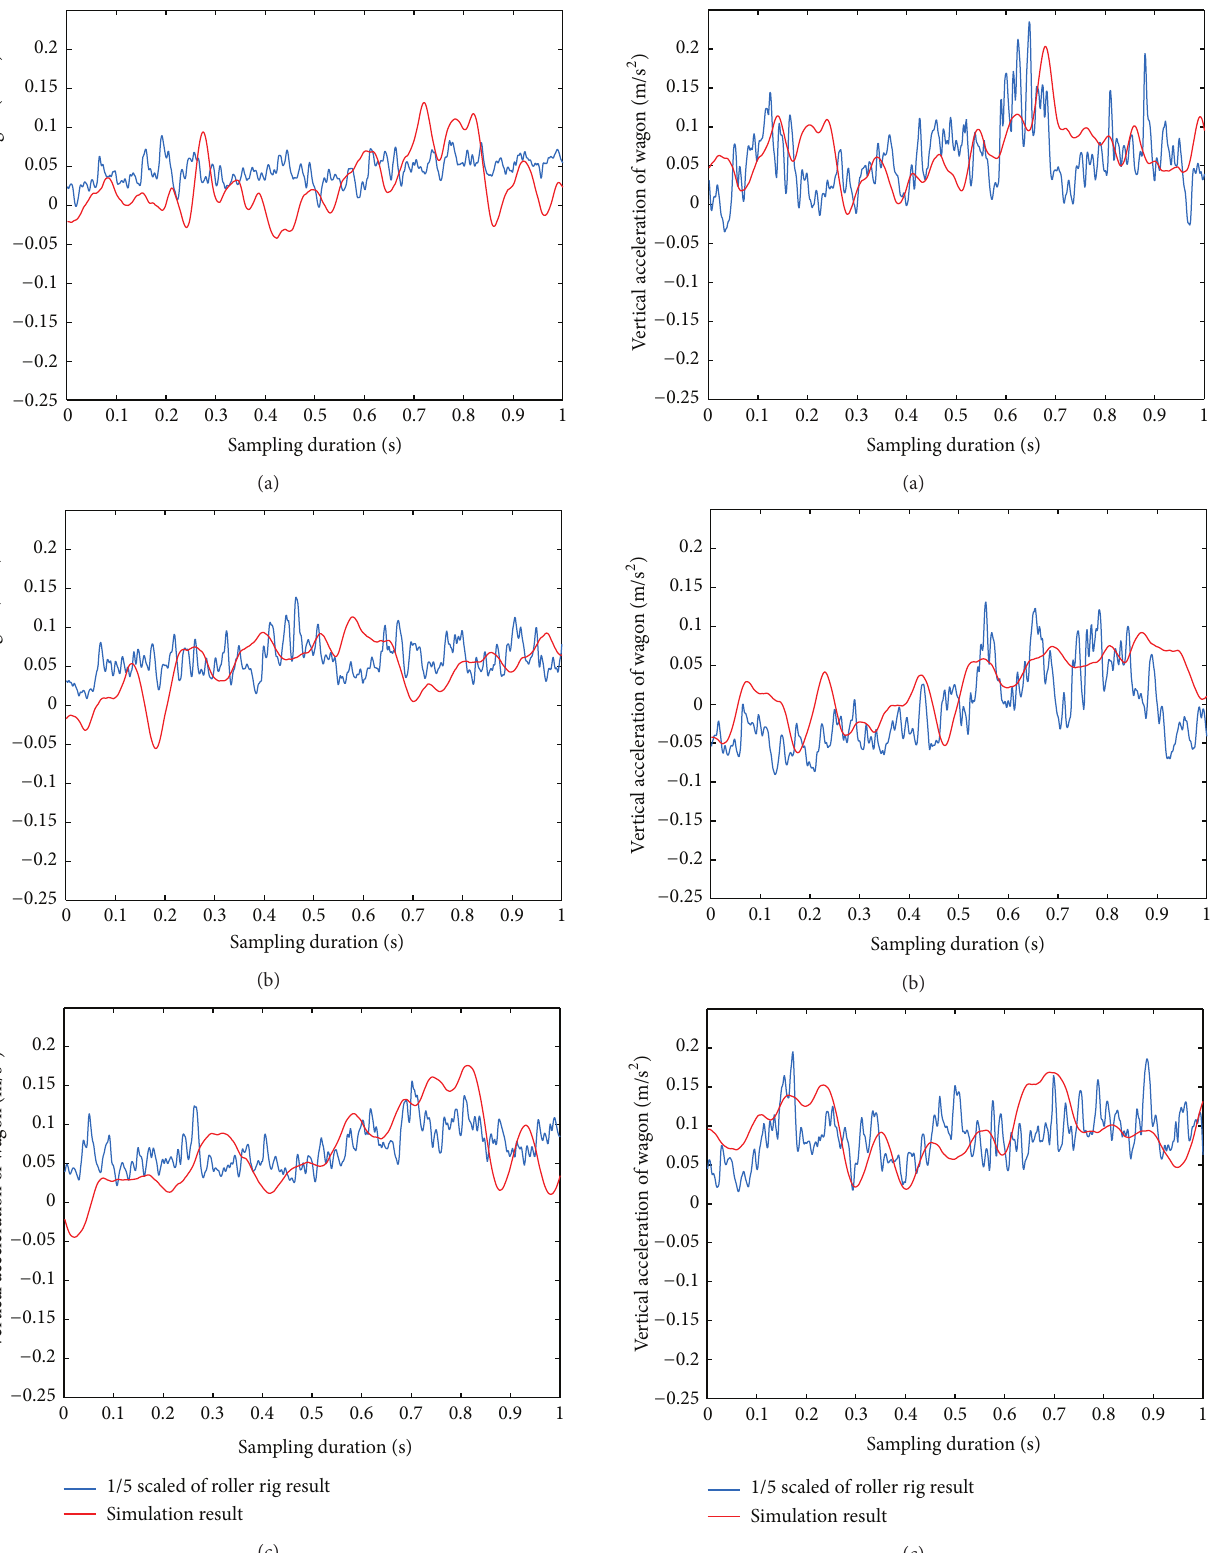
Figure 8: Vibration values of the rail vehicle with a half wagon of 20.75 tons moving in the horizontal plane on the bridge with an acceleration of 0.49 m/s 2 and with a velocity of (a) 150 km/h, (b) 200 km/h, and (c) 250 km/h.